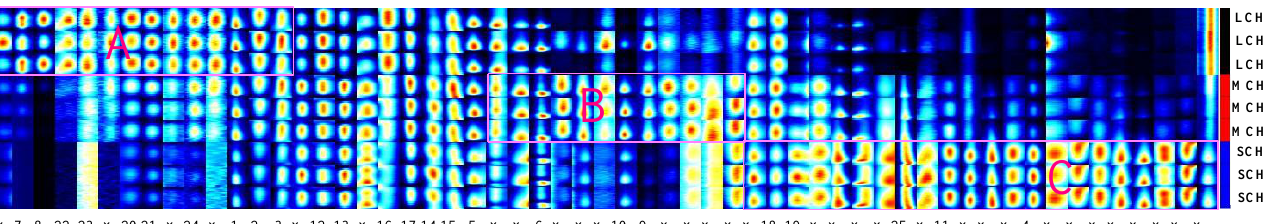
be volatilized at room temperature [30]. Their retention times were between 110.73 s and 789.98 s, drift time ranged from 1.05 ms to 1.56 ms and the carbon chain length was between C 2 and C 9 . Region “A” “B” and “C” which contained 14, 11 and 22 substances in Figure 2 represented the characteristic volatiles of LCH, MCH and SCH, respectively. There were 10 identified components in LCH samples, including ethanol (monomer and dimer), acetone, hexanal (monomer and dimer), pentanal (monomer and dimer), methylpyrazine, hexanoic acid and n-nonanal. While only three and five identified compounds existed in the characteristic volatiles of MCH and SCH, respectively.